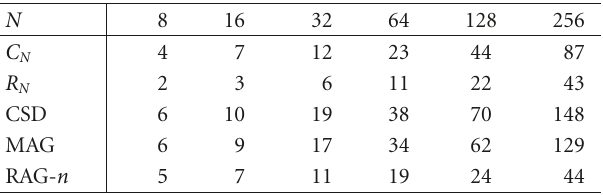
Table 2: Number of coe ffi cients and costs of a CZT multiplier block implemented with 12-bit plus sign coe ffi